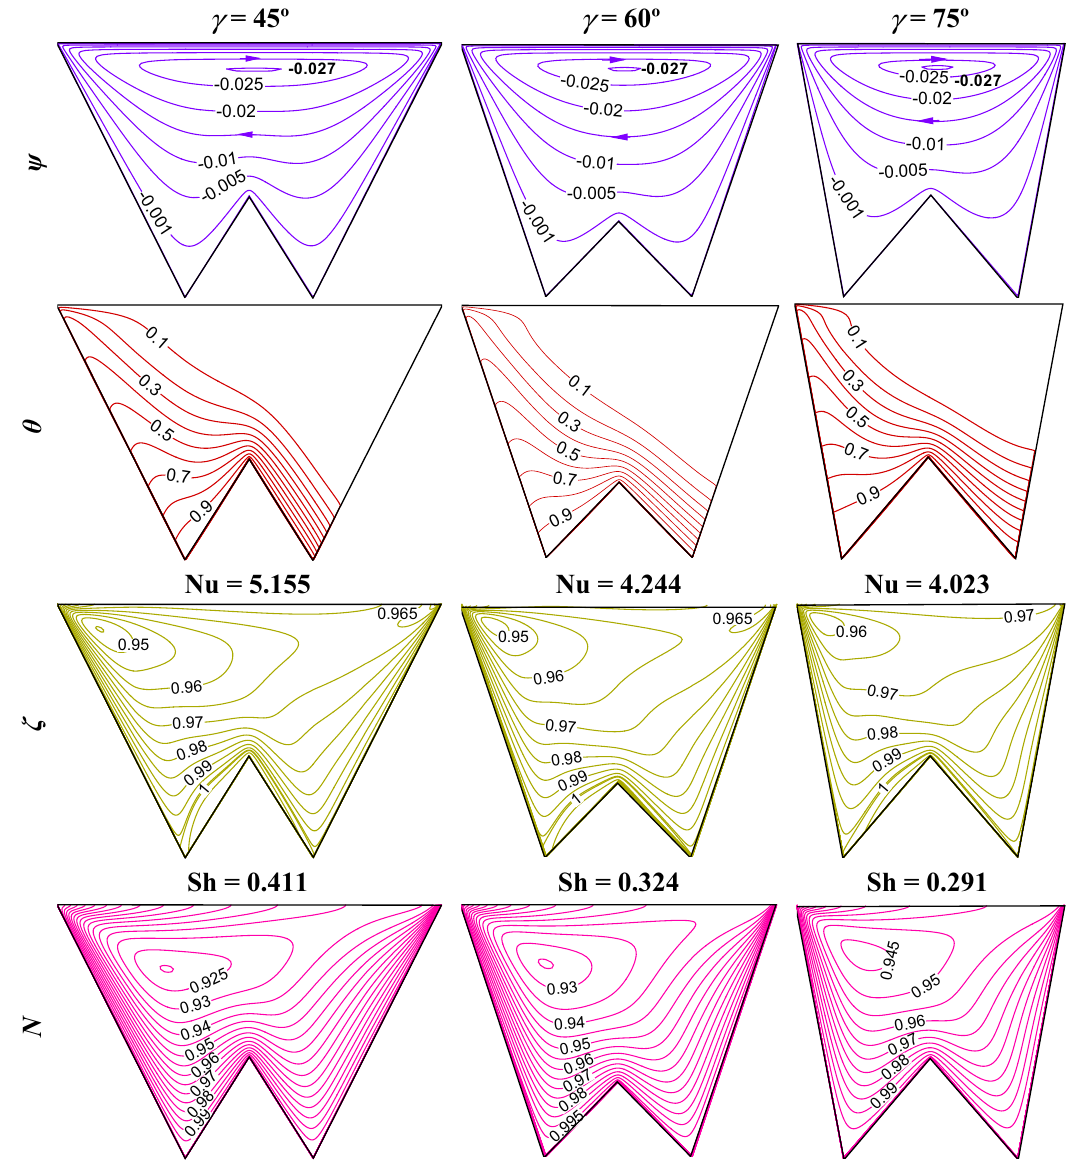
Figure 13. Streamline contours ( ψ ), Isotherms contours ( θ ), Oxygen isoconcentration ( ζ ), Microorganisms isoconcentration ( N ) for different side angles ( γ ) at R b = 50, Le = Pe = 1, Gr = 10 3 , Da = 10 –3 , Ha = 30, m = 1, δ =